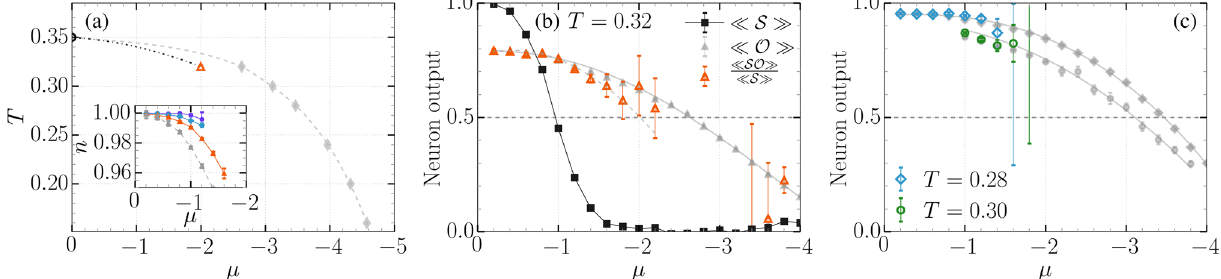
FIG. 4. Phase transitions away from half filling. (a) Magnetic phase diagram of the 3D Hubbard model away from half filling for U ¼ 9 . Empty red (filled grey) symbol(s) are estimates for the Néel temperatures, taking (not taking) the minus sign problem into account, obtained from a neural network that is trained to identify the phase at half filling. Lines are guides to the eye. Inset: Equations of state (density vs μ ) for U ¼ 9 at T ¼ 0 . 24 , 0.28, and 0.32 (solid lines from top to bottom, respectively). The grey dashed line is calculated without taking the sign problem into account at T ¼ 0 . 32 . (b) Average neuron output O calculated taking (without taking) the sign into account at T ¼ 0 . 32 ( ⟪ SO ⟫ = ⟪ S ⟫ and ⟪ O ⟫ , respectively). See Appendix A for details. The grey dotted line is a fit to the data near the 0.5 crossing point. (c) Same as in panel (b) but for T ¼ 0 . 30 and